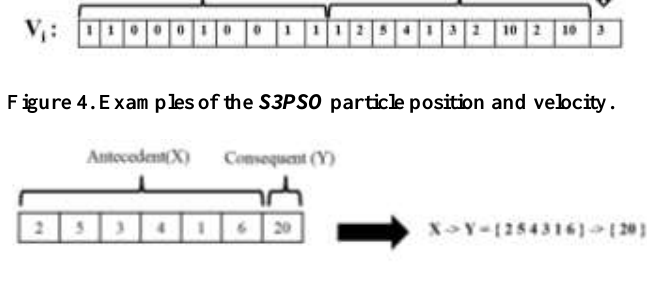
Figure 5. Encoding format of classification rules in the